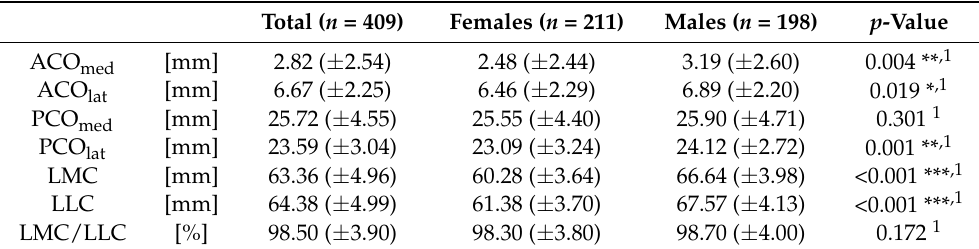
Table 5. Analysis of gender-specific differences for femoral condylar parameters in patients with radiologically healthy knee joints ( n = 409).